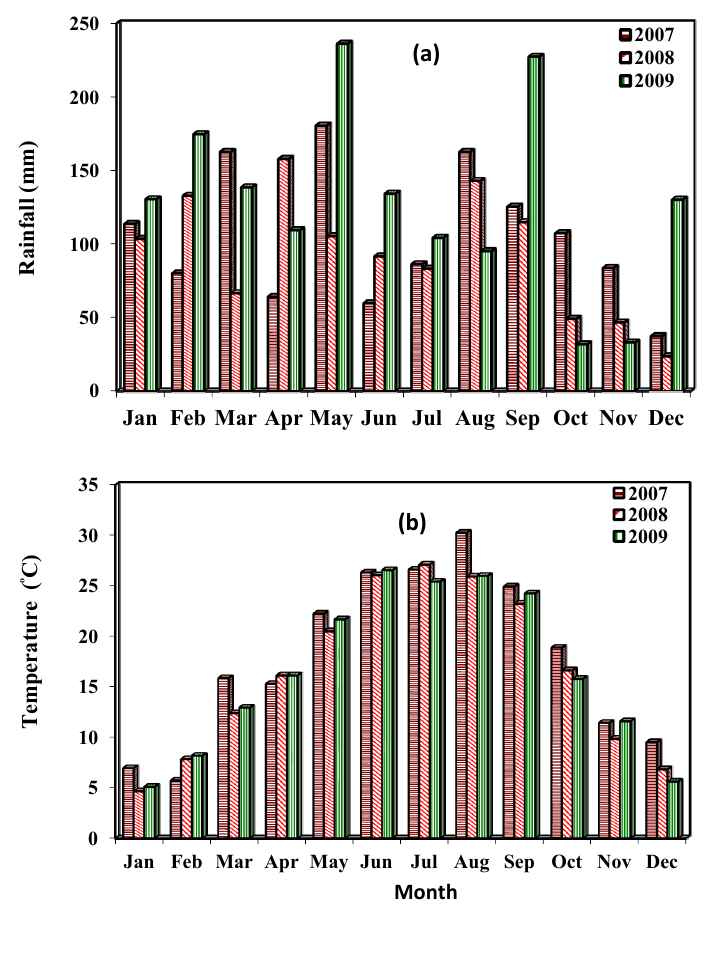
Figure 1. Temporal trends in ( a ) monthly rainfall totals (mm) and ( b ) monthly mean temperature (°C) during the study period, 2007 to 2009, Aberdeen, MS,